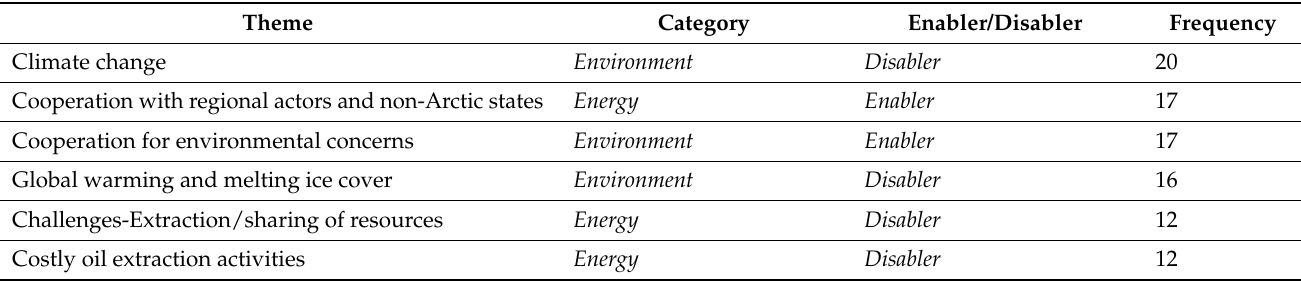
Table 2. Frequency of main themes—expert perspective.